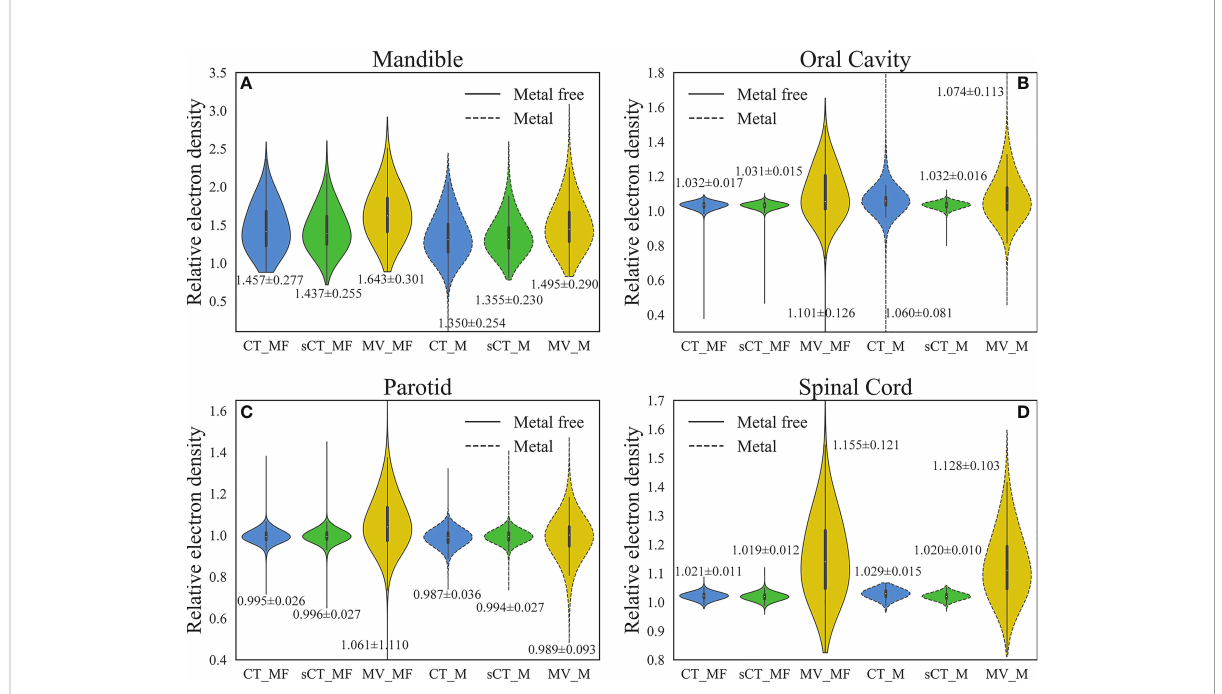
FIGURE 4 Comparison of RED distributions for OARs. (A) Mandible. (B) Oral cavity. (C) Parotid. (D) Spinal cord. The numbers marked in the fi gure are the average ± standard deviation. The RED values of the main OARs in sCT_MF images were accurate, and the inaccurate RED values caused by metal artifacts in CT_M images were corrected in sCT_M images after the MAR stage.